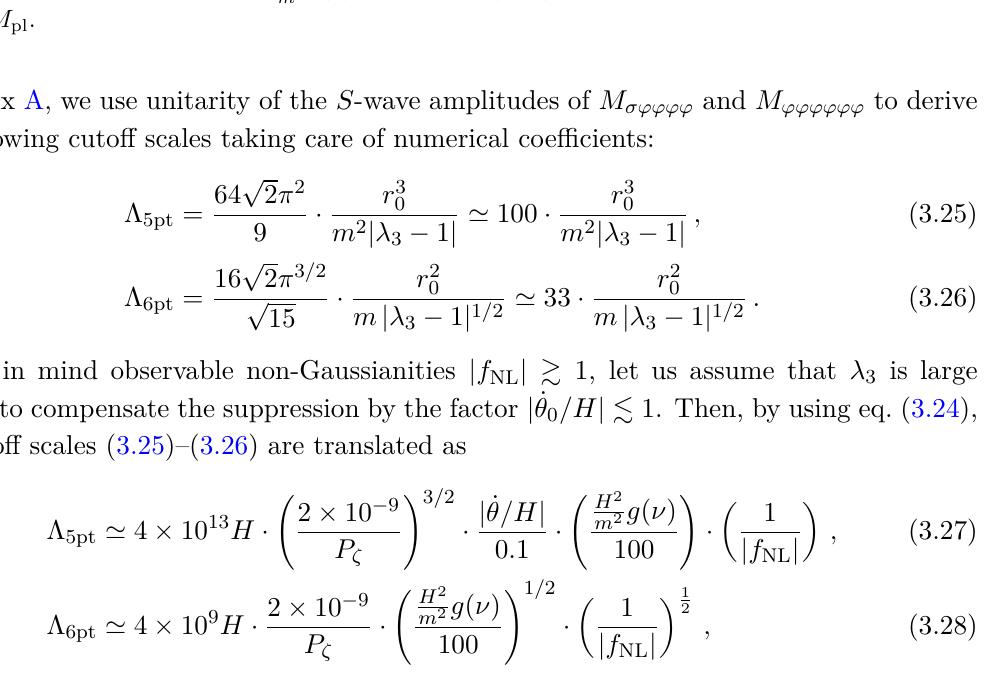
Figure 6 . Cutoff scale Λ 6pt vs Hubble scale H : as a benchmark point, we plot Λ 6pt = 4 × 10 9 H , which corresponds to the choice H 2 g ( ν ) = 100 and | f NL | = 1 . The blue region corresponds to m 2 Λ 6pt ≥ M pl